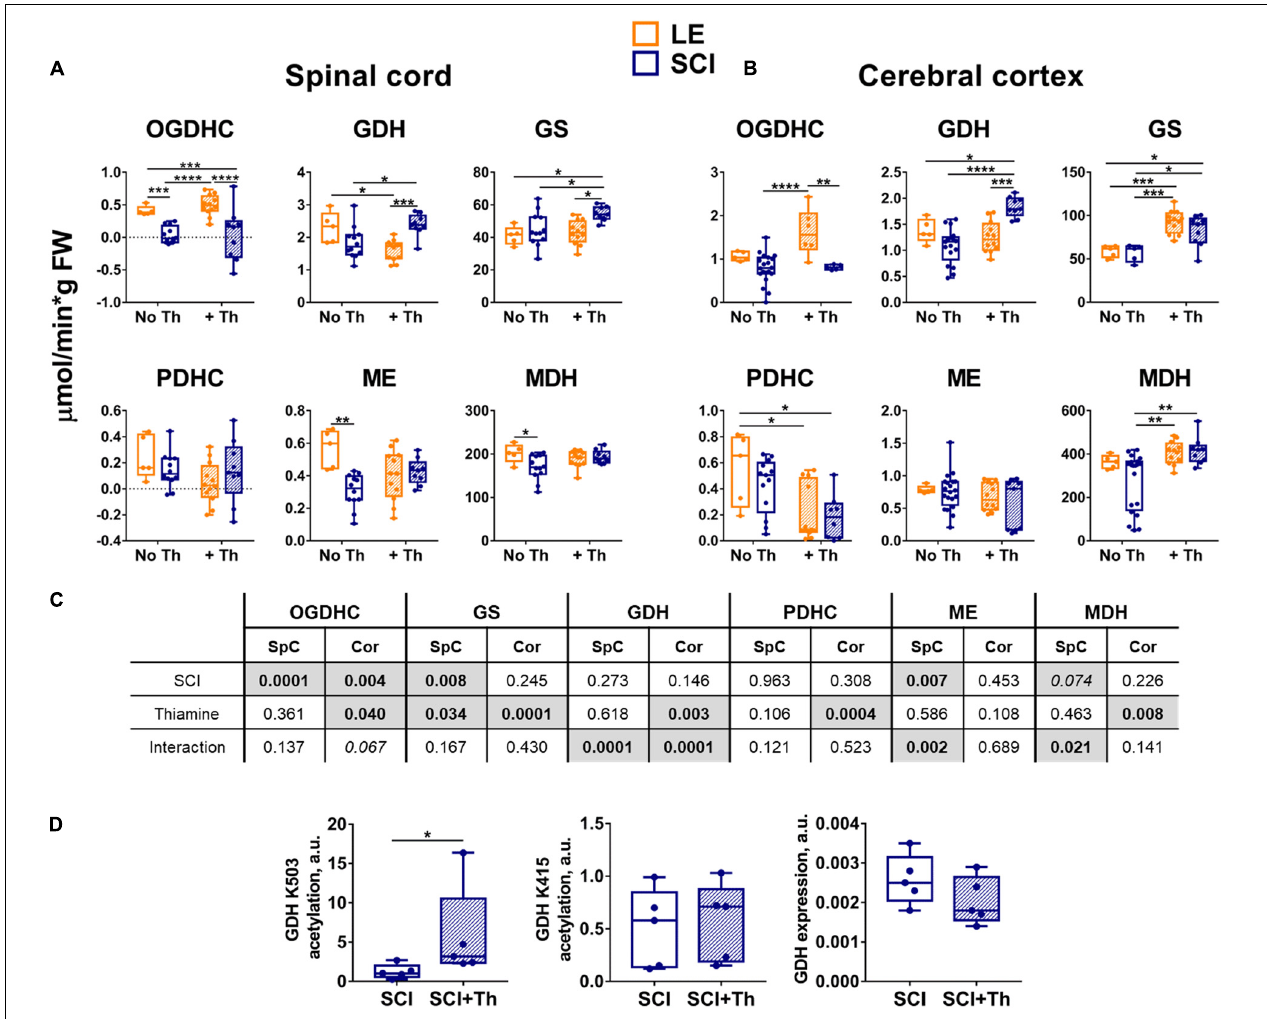
FIGURE 3 | Reactivities of the OGDHC and affiliated enzymes to the post-operative administration of the OGDHC pro-activator thiamine in the LE and SCI rats. (A) The enzymatic activities in the spinal cord (SpC). (B) The enzymatic activities in the cerebral cortex (Cor). (C) Significances ( p ≤ 0.05, in bold) and trends (0.05 < p ≤ 0.1, in italic) of the SCI and thiamine factors and their interactions, according to the two-way ANOVA of the data in (A,B) , are highlighted in gray. (D) Acetylation of the GDH residues K504 and K415 and the GDH expression: Acetylation level of K503 is normalized to the same peptide comprising the deacetylated K503; acetylation level of K415 is normalized to the sum of the two reference GDH peptides, which are also used for the estimation of the GDH expression; significance of differences between the two groups is estimated using Mann-Whitney’s test. Thiamine is administered intraperitoneally at a dose of 1.2 mmol/kg within 24 h after operation. On the graphs, different p -values are shown by asterisks as described in Methods under Statistical Analysis. Number of animals in each group: LE, n = 5; SCI, n ≥ 5; LE + Th, n ≥ 6; SCI + Th, n ≥